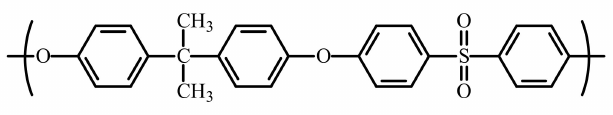
Figure 1. The chemical formula of the polysulfone UDEL ® type.